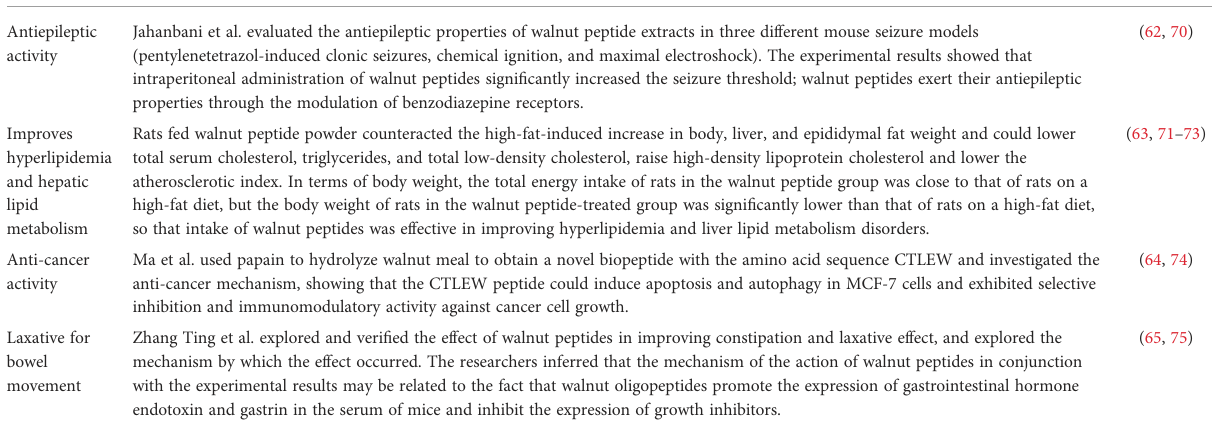
TABLE 6 Other activities of walnut